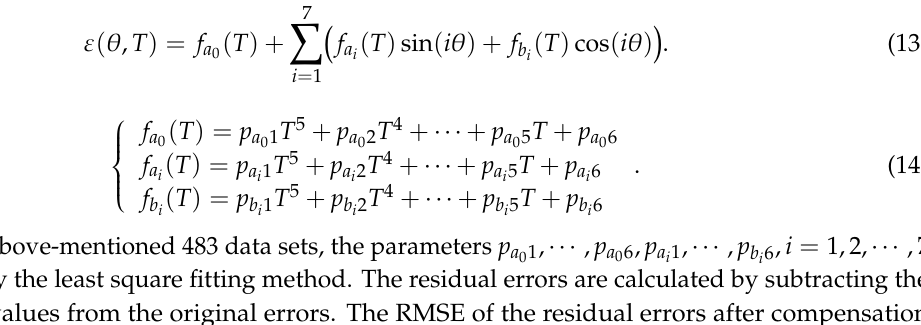
Figure 10. Compensation effect of the two-dimensional polynomial fitting method.